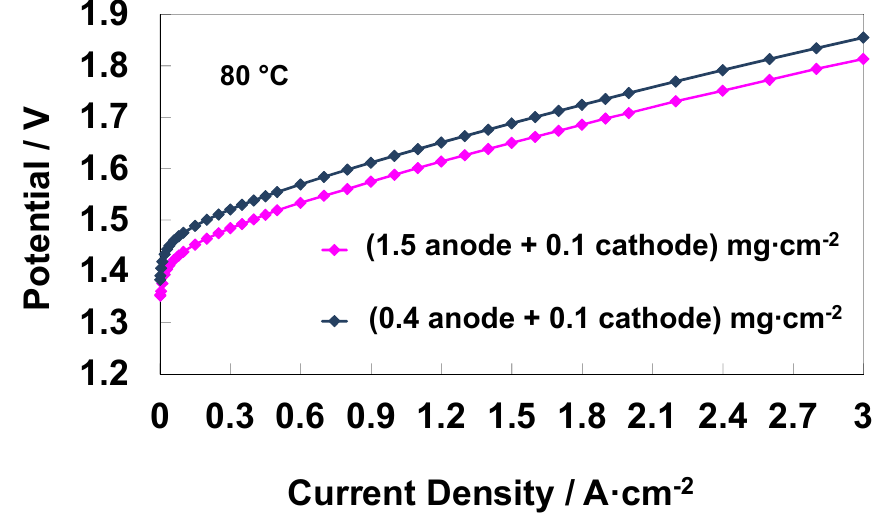
Figure 7. Comparison of the water electrolysis polarization curves for different anode catalyst loading -based MEAs at 80 °C.